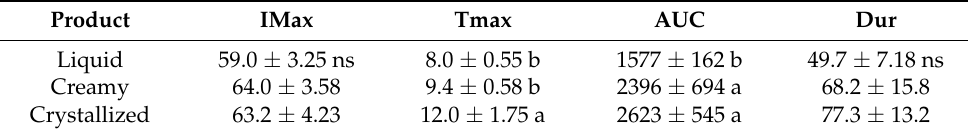
Figure 4. Time intensity curves for rape honey samples. Table 6. Time intensity parameters ( ± SEM) for the citrus honey overall olfactory intensity. Product